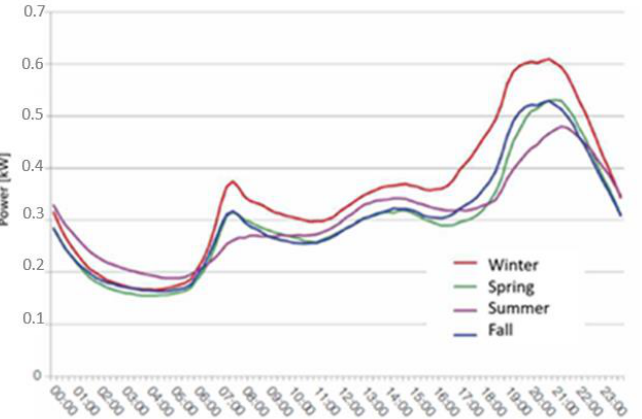
Figure A1. Italian typical residential load curve for a weekday and for different seasons (source: RSE [30]).